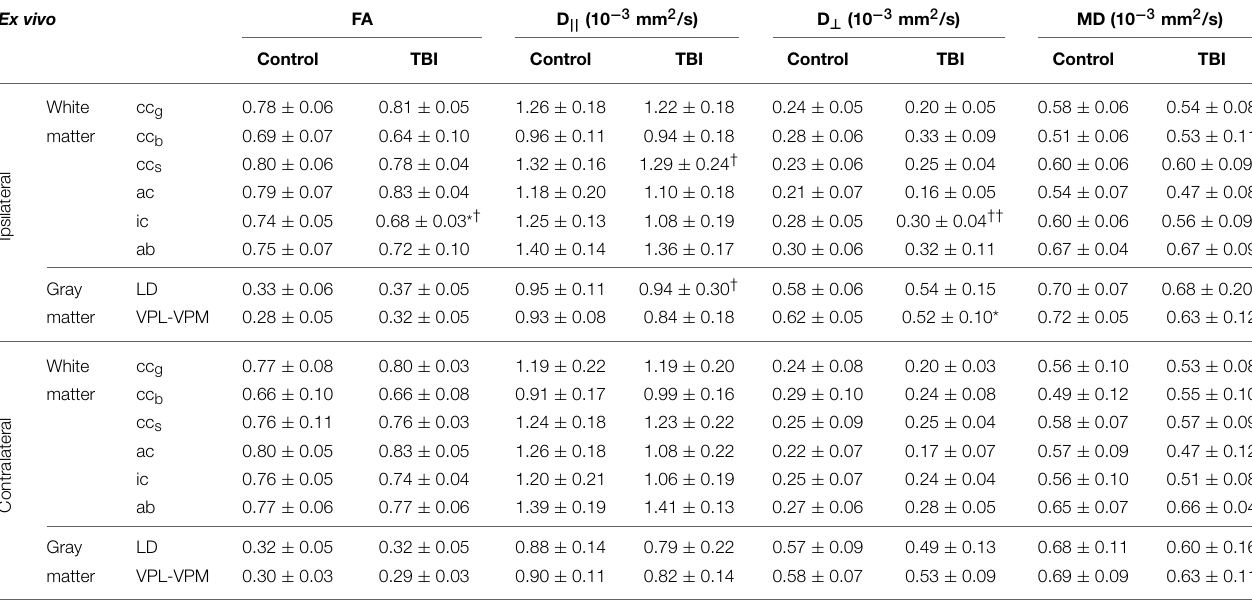
TABLE 1 | Fractional anisotropy (FA), and axial (D || ), radial (D ⊥ ), and mean (MD) diffusivities from ipsilateral and contralateral hemispheres in controls ( n = 7 ) and rats after TBI ( n = 8 ) obtained using ex vivo DTI. Ex